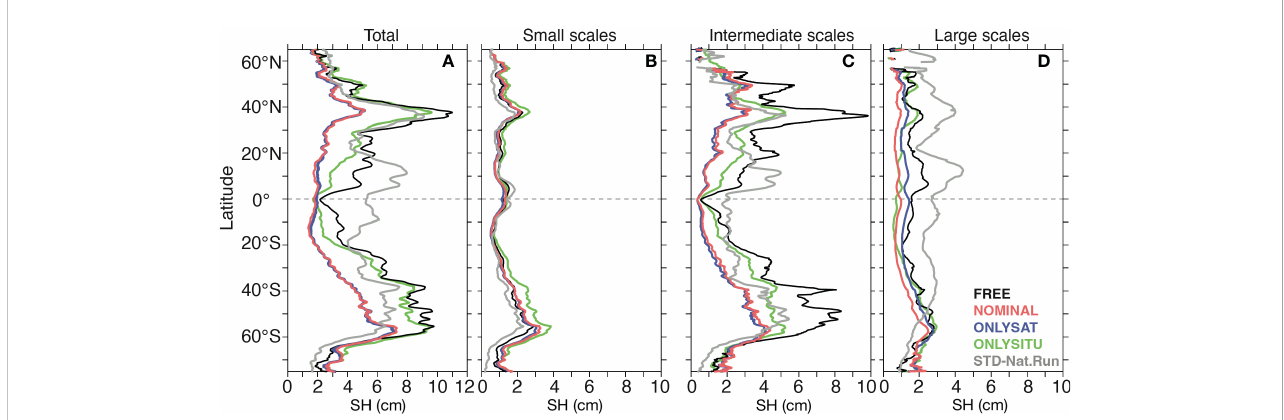
FIGURE 5 Zonally averaged steric height (SH, cm) RMS difference between the Nature Run and experiments (FREE, NOMINAL, ONLYSAT, ONLYSITU) for the total (A) , the small scales (smaller than 1°x1°x20-day, B ), mesoscale (between 1°x1°x20-day and 9°x9°x90-day, C ) and large variability (larger than 9°x9°x90- day, D ). For comparison, the standard deviation of the Nature Run SH, zonally-averaged, is also shown